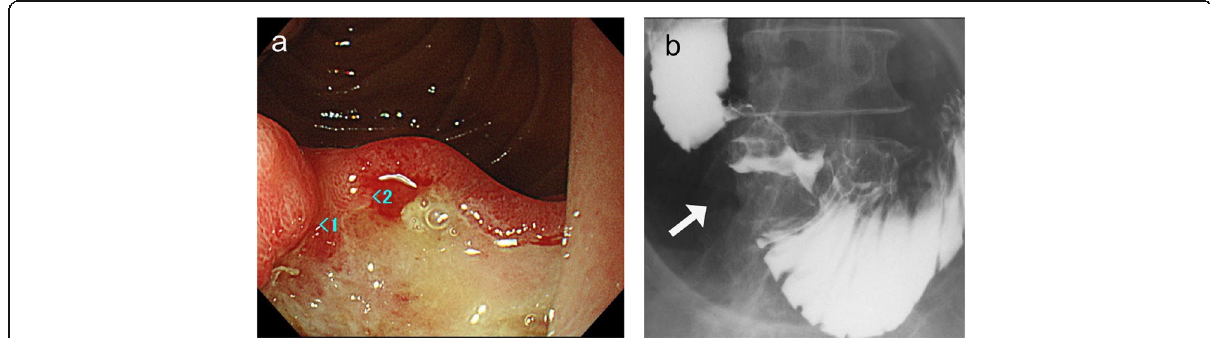
Fig. 2 a Upper gastrointestinal endoscopy revealed a large, hemorrhagic, ulcerative tumor with an irregular border in the second portion of the duodenum. b X-ray radiography showed an ulcerative tumor 4.5 cm in diameter with an irregular border